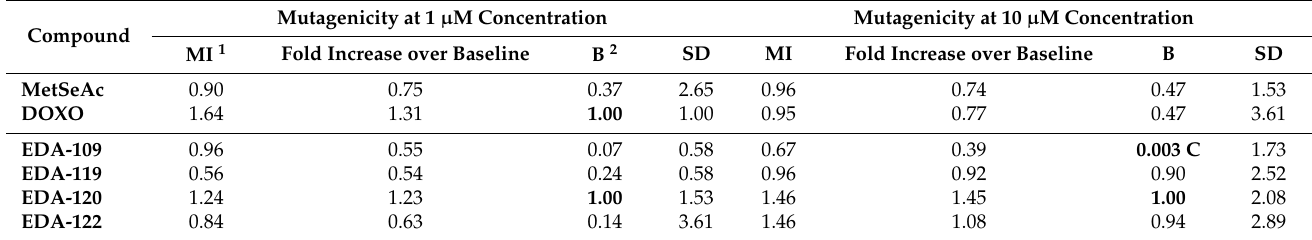
Table 3. Mutagenic index (MI) and other values for methylseleninic acid (reference Se compound), doxorubicin (reference chemotherapeutic), and tested compounds with high cytostatic activity.